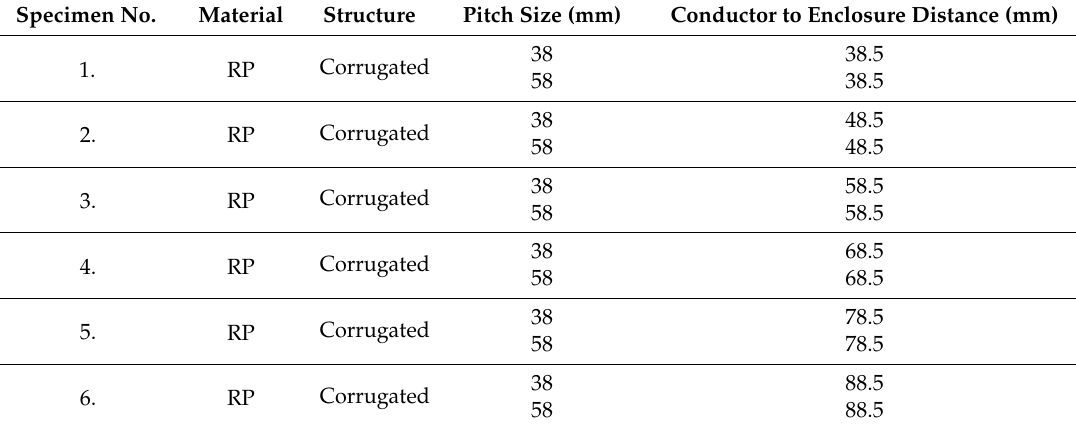
Figure 7. Comparison of field utilization factor regarding varied conductor to enclosure clearance. Table 2. Detailed specification of enclosure specimens used for field utilization comparison regarding conductor to enclosure clearance.